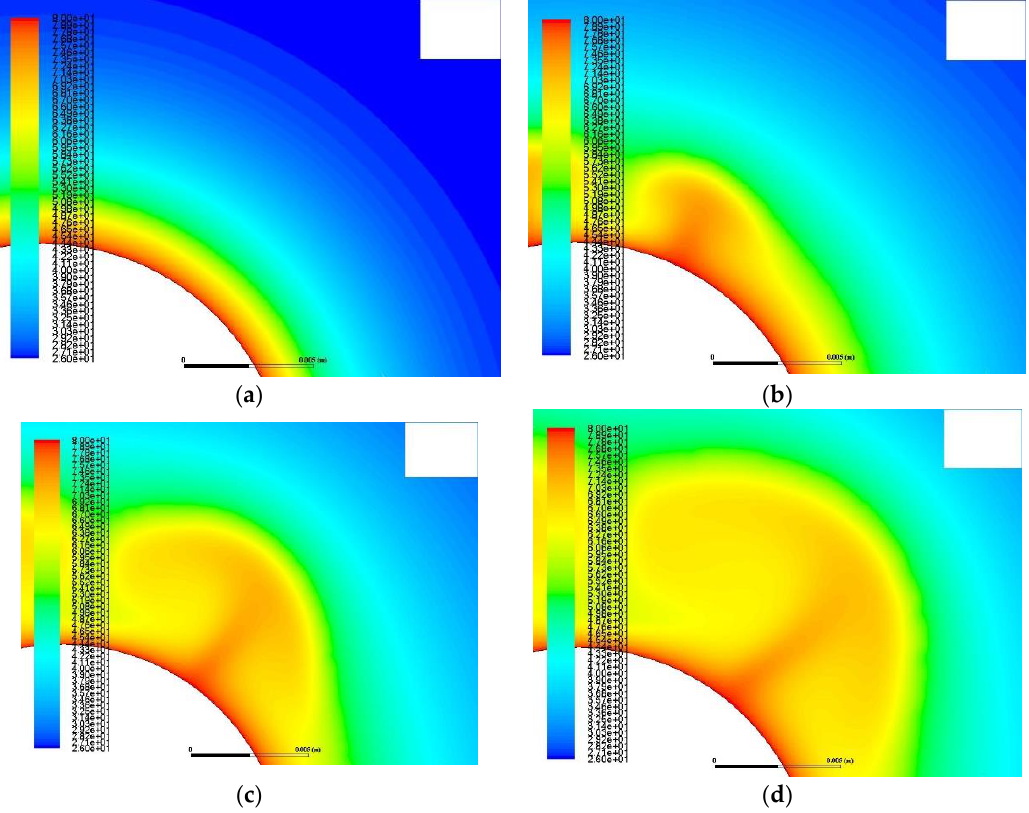
Figure 10. Variation of temperature field for 100 s ( a ), 300 s ( b ), 500 s ( c ) and 800 s ( d ). Energies 2020 , 13 , x FOR PEER REVIEW